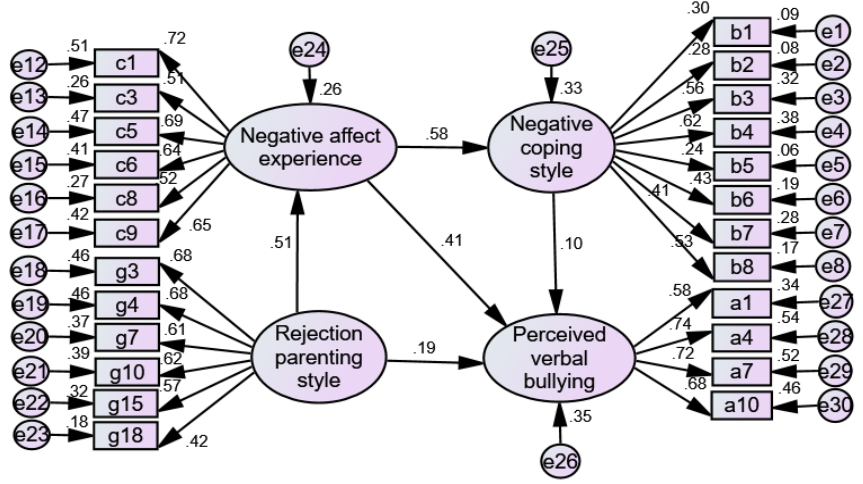
Figure 2. The chain-like mediating effect of negative affect experience and negative coping styles between rejection parenting style and the perceived verbal bullying. Table 5. The model fitting goodness index table with the perceived verbal bullying as the dependent variable.